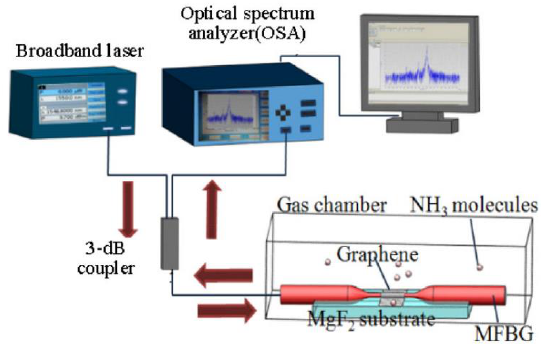
Figure 9. Schematic representation of the experimental setup used in the characterization of an ammonia sensor consisting of a graphene-coated eFBG. Reprinted with permission from [116].